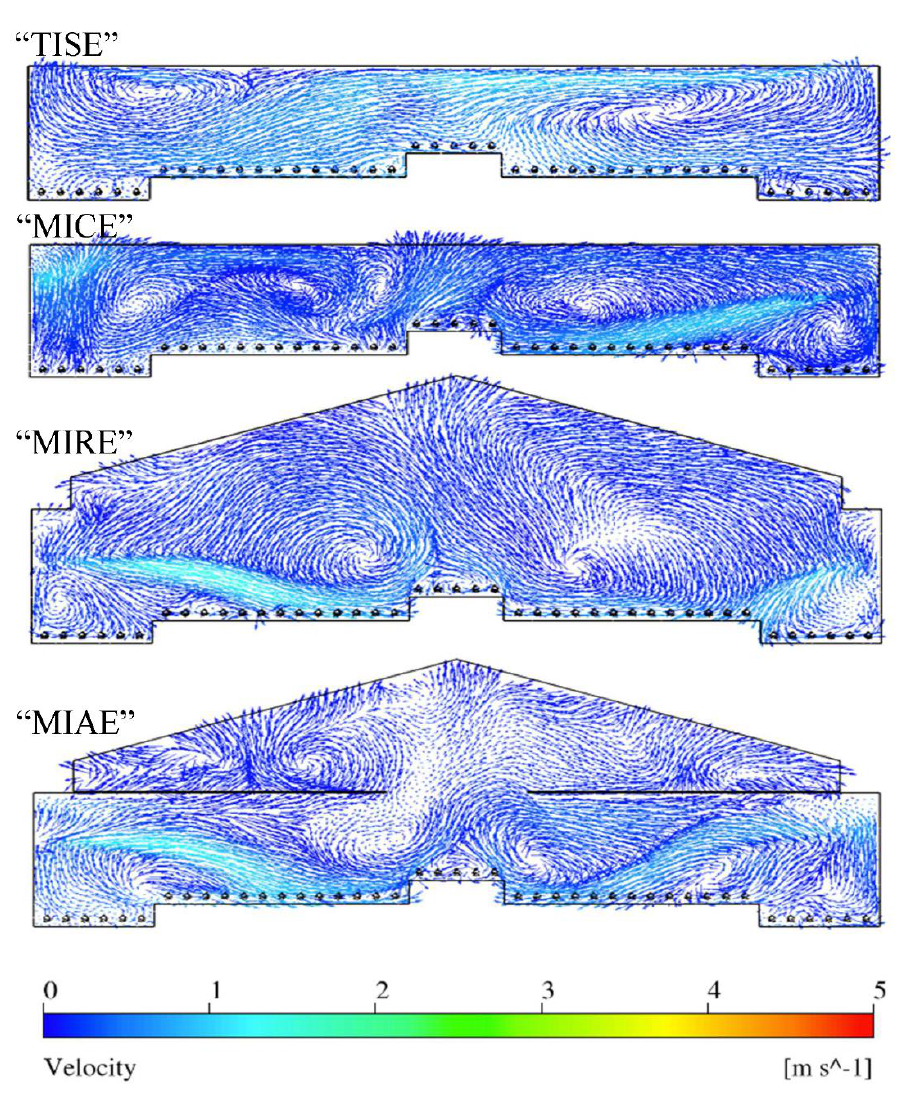
Figure 7. Indoor air velocity vector contours at Plane N of four models. The air movement patterns at Plane F exhibited the influence of the exhaust fan on performance of each model (Figure 8). The TISE model presented different patterns compared to the other three models due to the distinct sidewall location of the fan. Air speeds at the right portion of the layer house increased gradually as approaching the fan area in TISE. However, a vigorous horizontal airflow was observed within the left